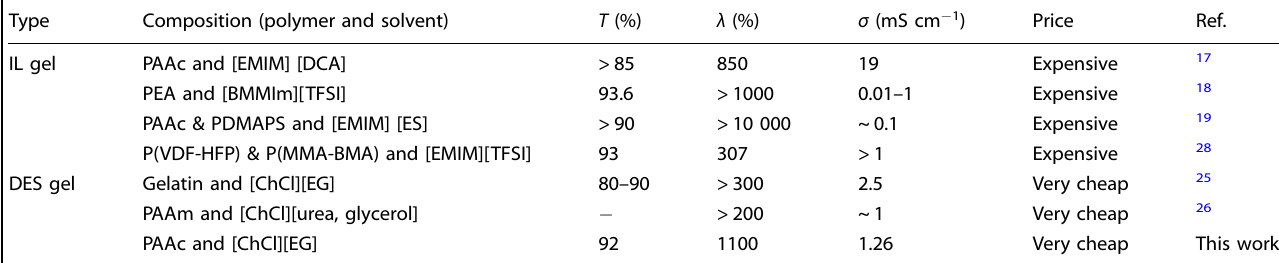
Table 1. Comparison of our work with representative IL gels and DES gels.